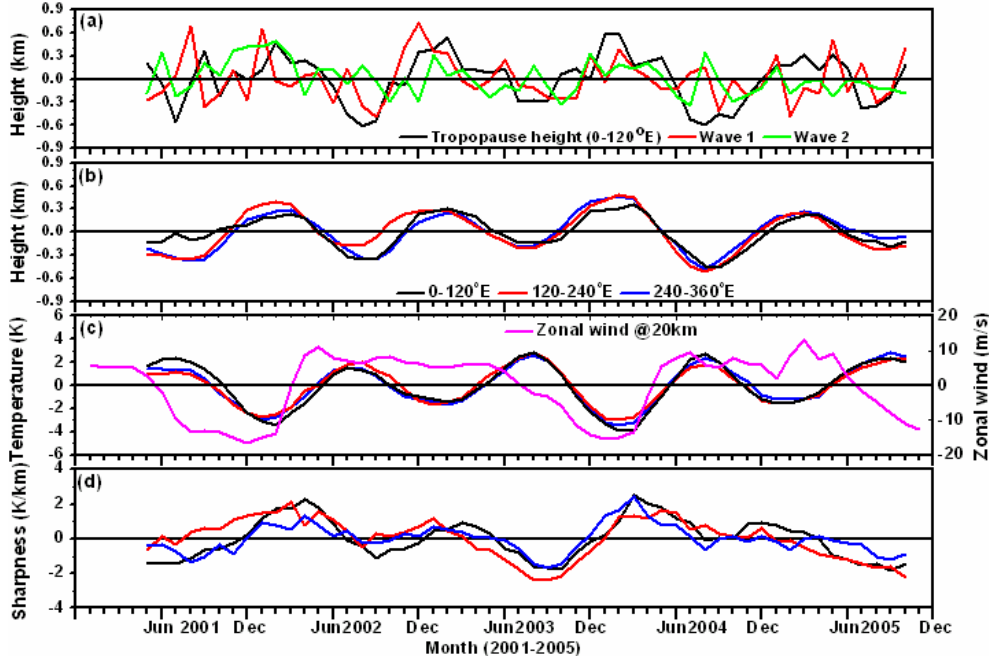
Figure 9. Temporal variation of anomalies derived from climatological means (four and half years) of (a) cold point tropopause height (black) observed at the equator (±5 o ) at 0-120 o E longitude during May 2001-October 2005. Amplitudes of Kelvin waves for both wave number 1 (red) and 2 (green), observed at 17 km altitude is also plotted. (b) Tropopause height observed at the equator (±5 o ) at 0-120 o E, 120-240 o E, and 240 o E -360 o longitude bands. Note that 5 month smoothing was applied for this panel to show the inter-annual variations. Corresponding temporal variation of anomalies observed in (c) temperature, and (d) tropopause sharpness (see text). Monthly mean zonal velocity (magenta) observed at 20 km taken from Singapore radiosonde is plotted in (c) and the amplitudes are shown on the right side. Mean tropopause height, temperature and sharpness is found to be 17km, 191K, and 10K/km, respectively.